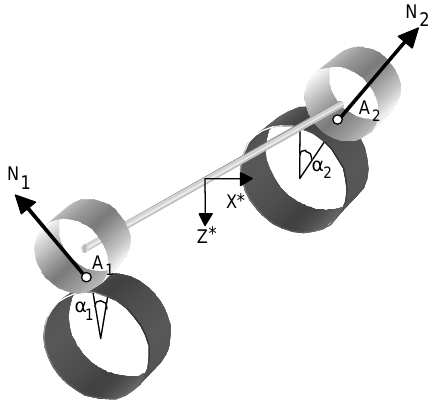
Fig. 6. The normal forces in the two contact points A1, A2 have opposite directions and different slopes. Here, in particular, α 1 > α 2